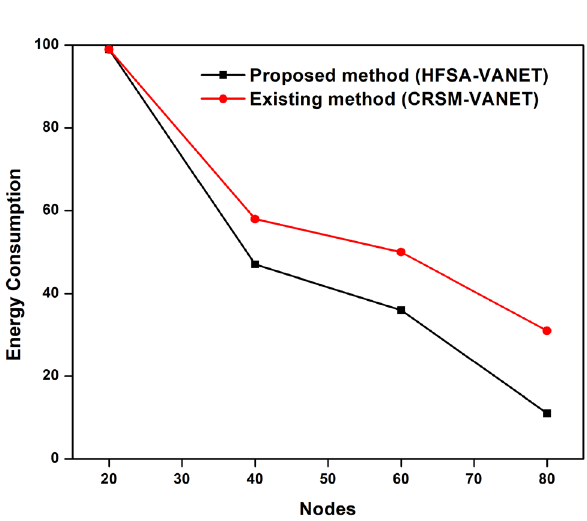
Figure 4. Energy consumption plot for a proposed and existing